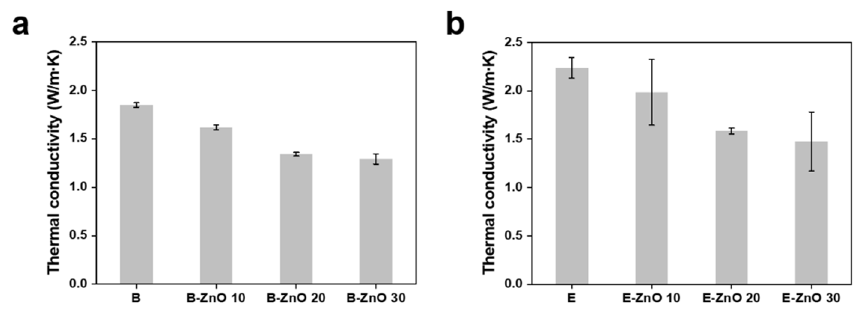
Figure 4. Thermal conductivities of thermal pads using aluminum oxide and zinc oxide powder with ( a ) 20 wt% PDMS or ( b ) 15 wt% PDMS. The bar graph illustrates the mean and standard deviation (error bars).